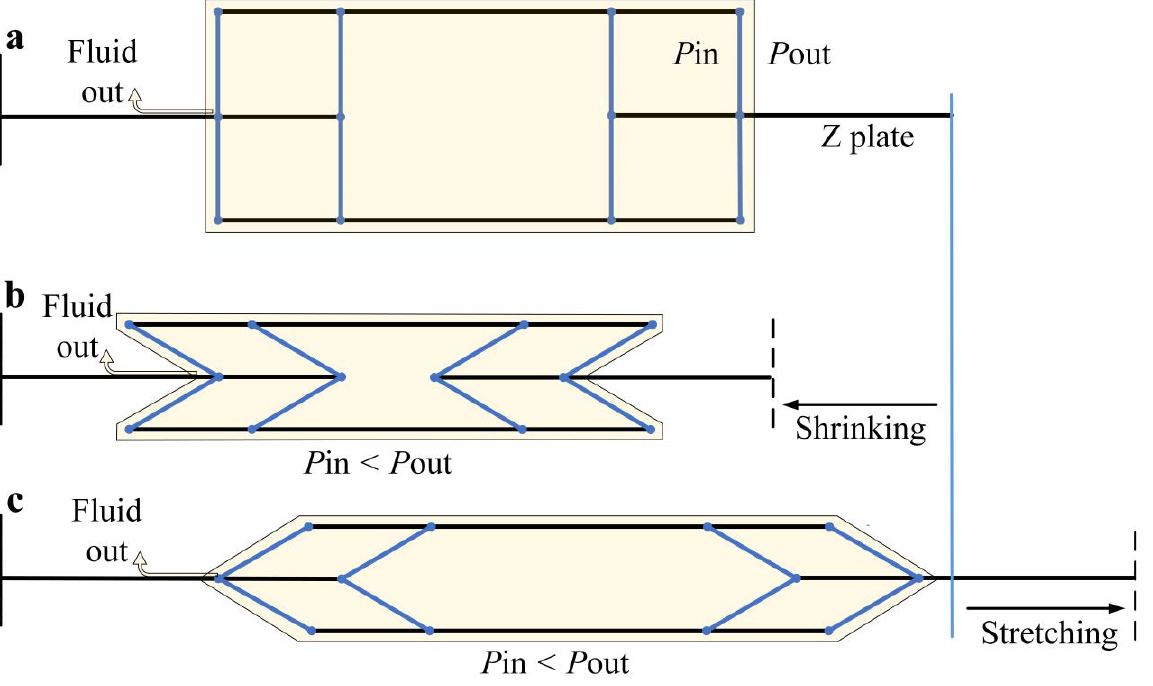
Figure 1. The folding structure’s state evolvement: ( a ) A flexible actuator in the initial state; ( b ) The flexible actuator is shrinking; ( c ) The flexible actuator in stretching.